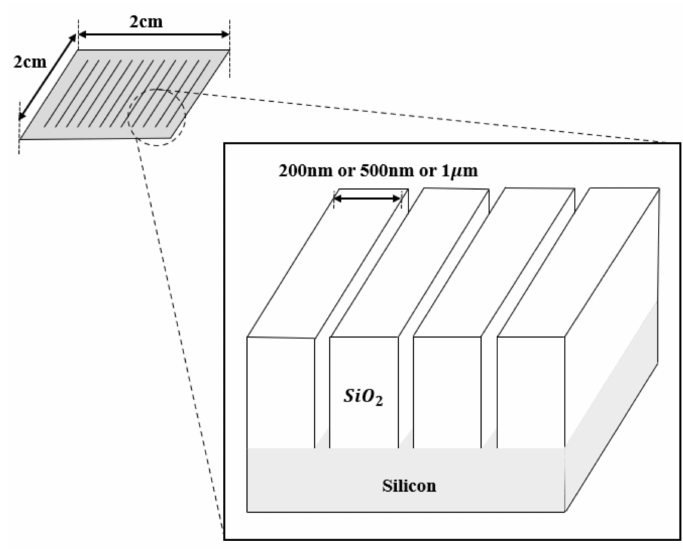
Figure 3. Schematic of the sample coupon.